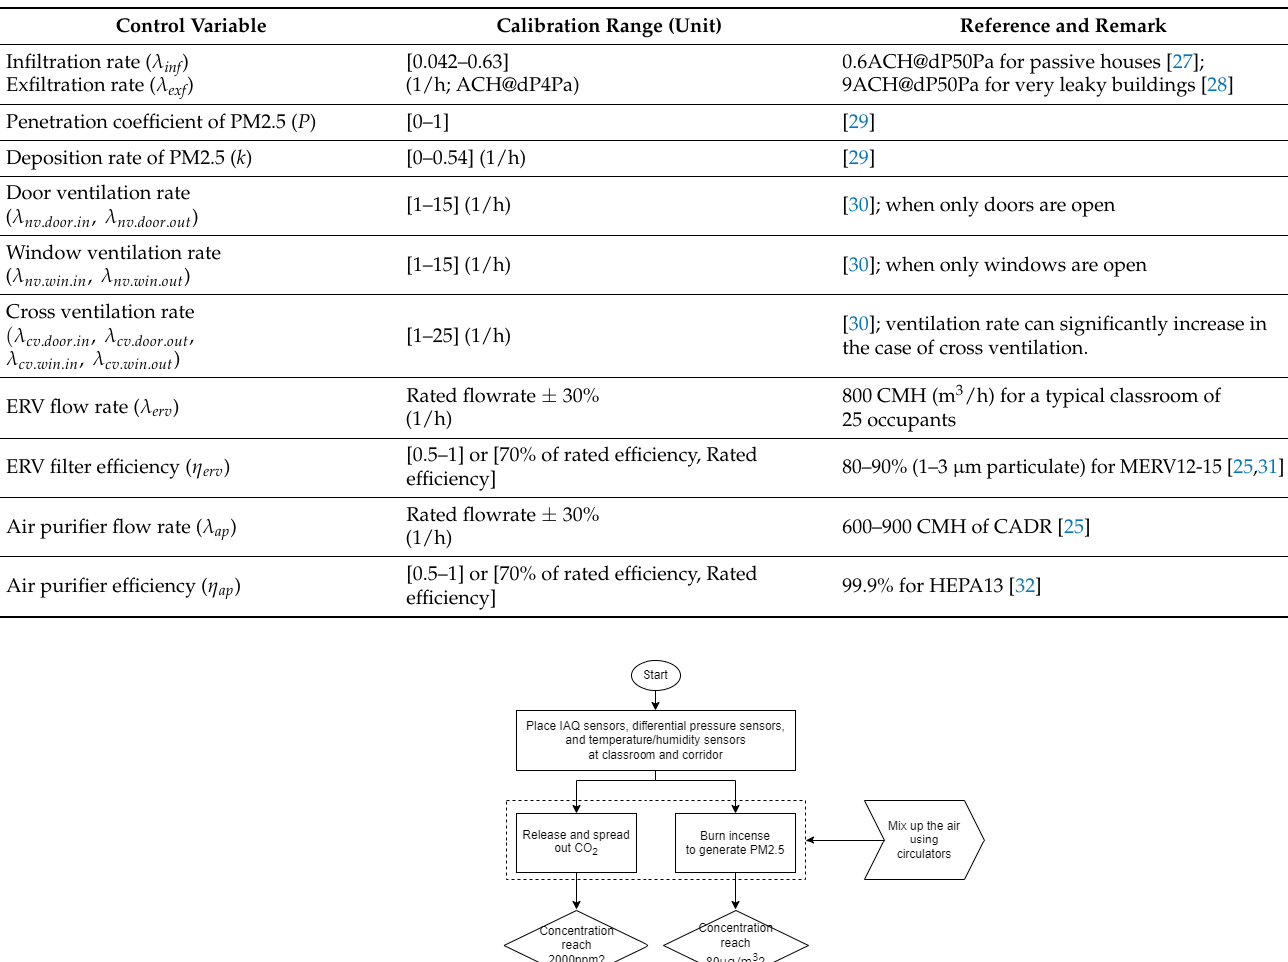
Table 1. Calibration range of the control variable in domestic school context.